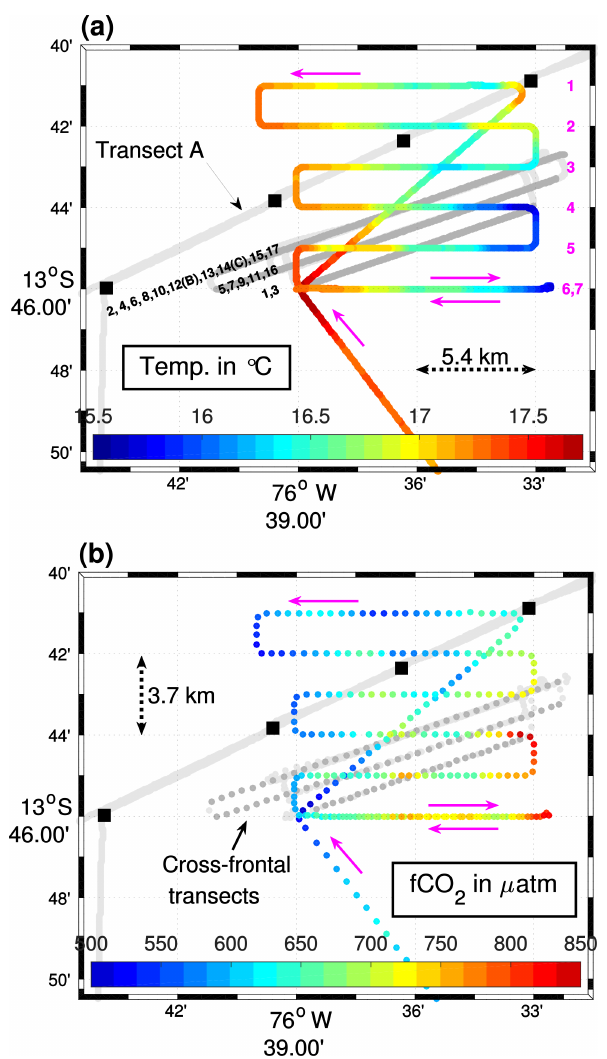
Figure 2. Sampling map of underway temperature (a) and f CO 2 (b) along the cruise track. The solid light grey line shows the CTD section (transect A) conducted prior to the seven zonal transects, with black squares indicating CTD stations. The 17 cross- frontal transects are marked by the dark grey lines (a) and dots (b) . The black numbers in (a) correspond to the cross-frontal transects. Transects 12 and 14 correspond to the high-resolution subsurface temperature transects B and C. Magenta arrows show the direction of the ship’s track and magenta numbers label the zonal transects. The area presented in both panels is depicted as a red square in Fig.